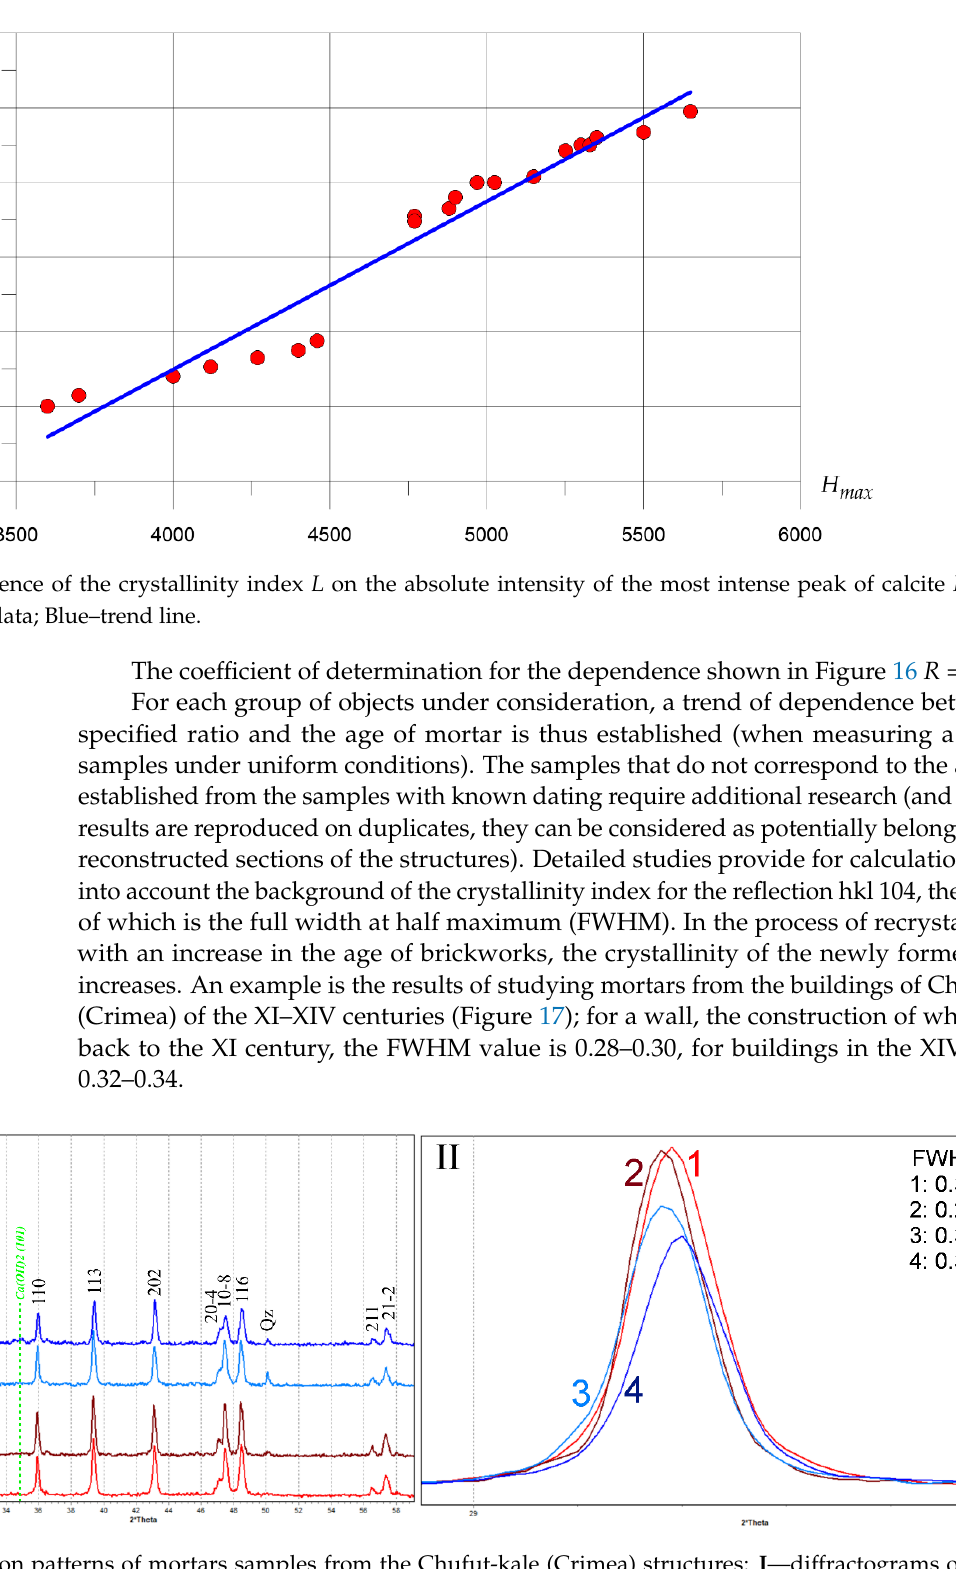
Figure 17. Diffraction patterns of mortars samples from the Chufut-kale (Crimea) structures: I —diffractograms of the samples, II —the shape of the peaks corresponding to the calcite peak (hkl) 104 calcite. Samples: 1, 2—old wall (sample E-20-KR-CHU-1, E-20-KR-CHU-2), XI century; 3—tomb (sample E-20-KR-CHU-4), 1380; 4—mosque (sample E-20-KR-CHU-5), 1347. Calcite hkl, quartz peaks (Qtz), position of the most intense portlandite reflex (101), FWHM values are indicated.